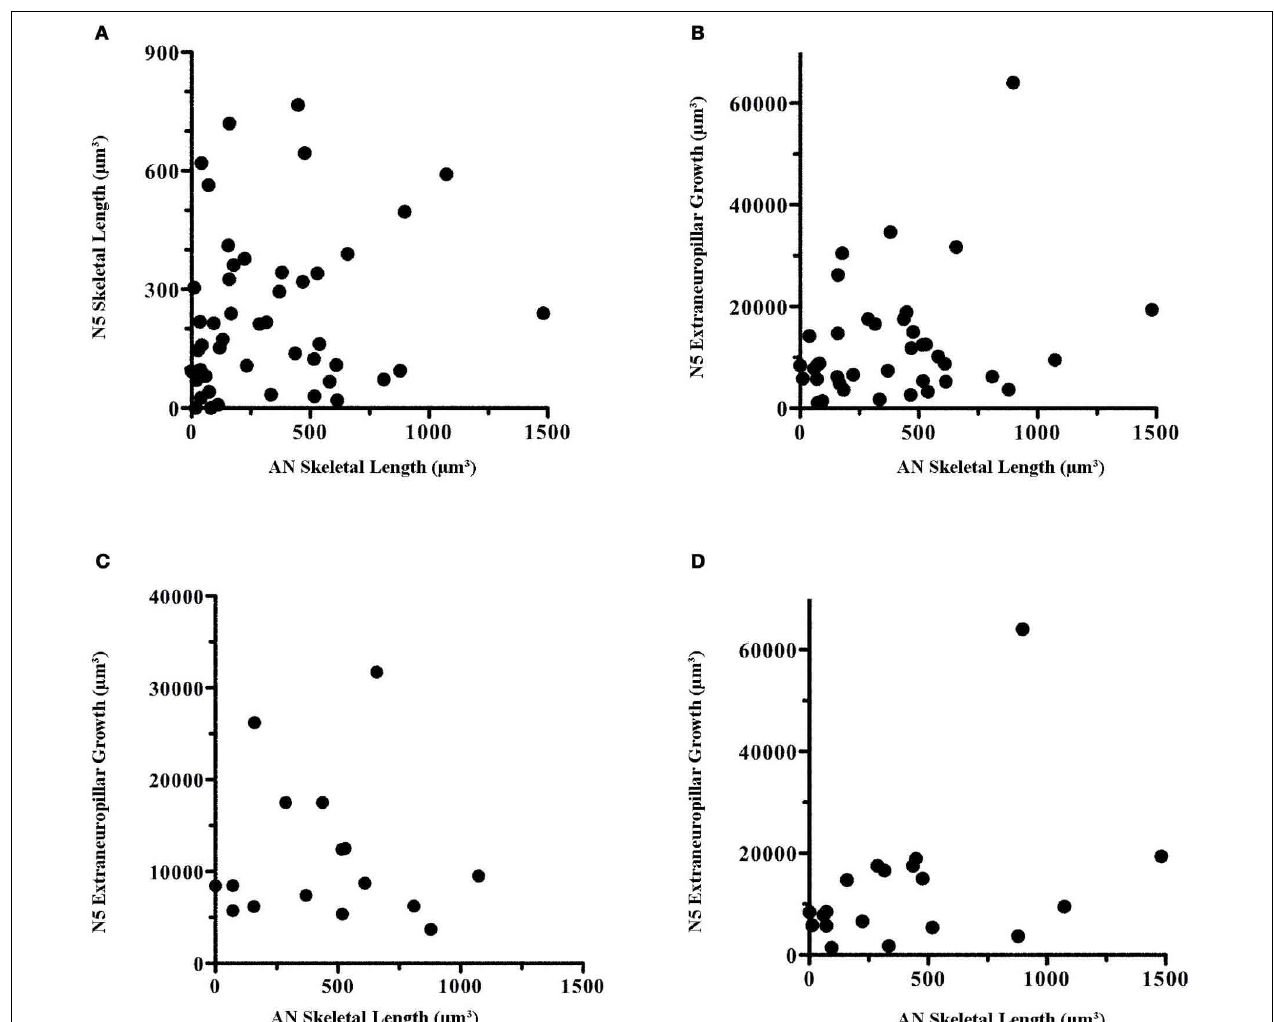
FIGURE 6 | Therewas nocorrelationintheamountofdendriticgrowthin comparisontoaxonal growthwithinindividuals. Within-animal AN skeletal length wascompared with (A) N5 skeletal length, (B) N5 extraneuropillar growth, and (C) N5 extraneuropillar growth at 5 and 7 days. (D) Male N5